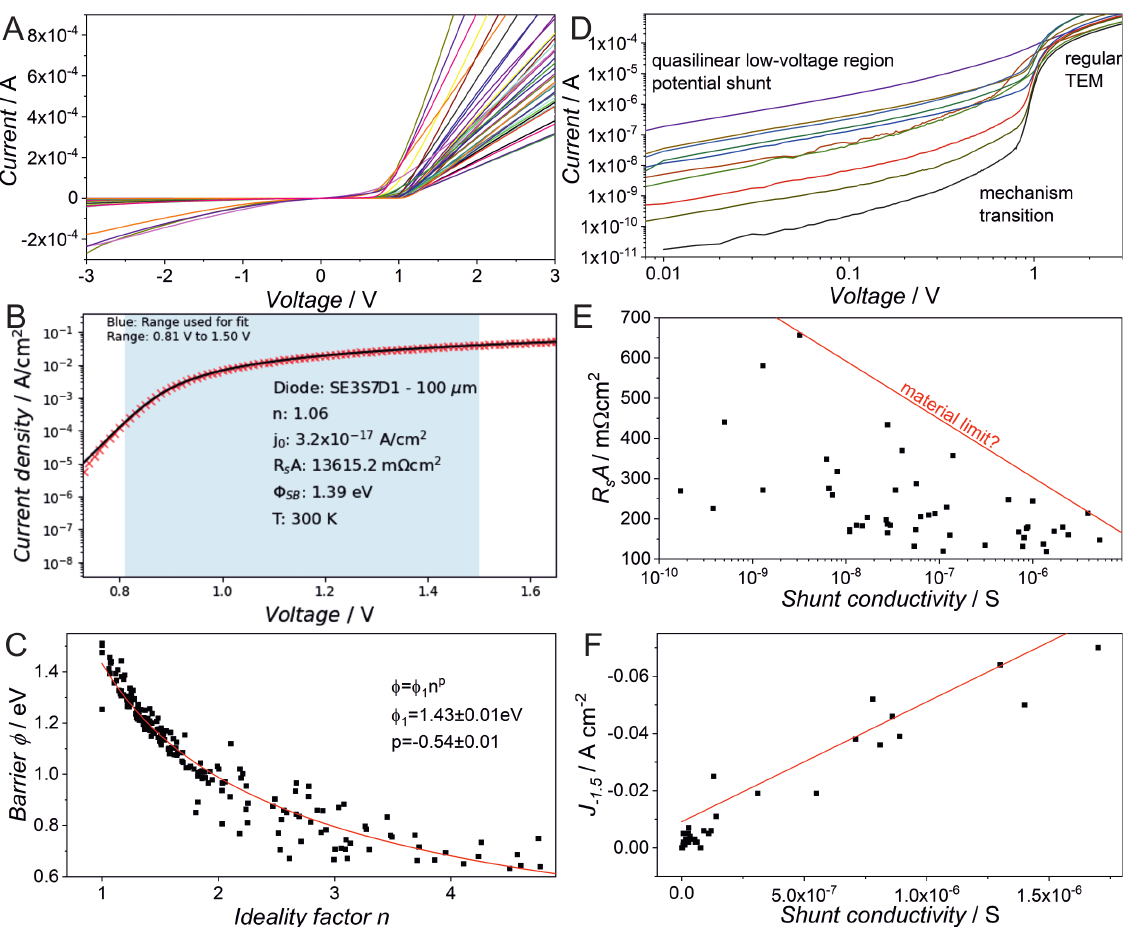
Figure 3. ( A ): Current–voltage plot for all characterized diodes in SE4 on sample II. If not specified otherwise, a positive voltage will be the forward direction and a negative voltage the reverse direction for all following data; ( B ): TEM model fit for diode SE3S7D1 on sample I; ( C ): correlation of the Schottky barrier φ SB and the ideality factor n for all investigated diodes on all samples; ( D ): double logarithmic plot for the low-voltage region for a set of diodes on sample II exhibiting an almost linear behavior; ( E ): plot of R s A vs. the shunt resistance for all 100 µ m diodes on the same sample; ( F ): plot of the leakage current density at − 1.5 V J − 1.5 for the same diodes exhibiting a linear correlation between low-voltage forward and reverse